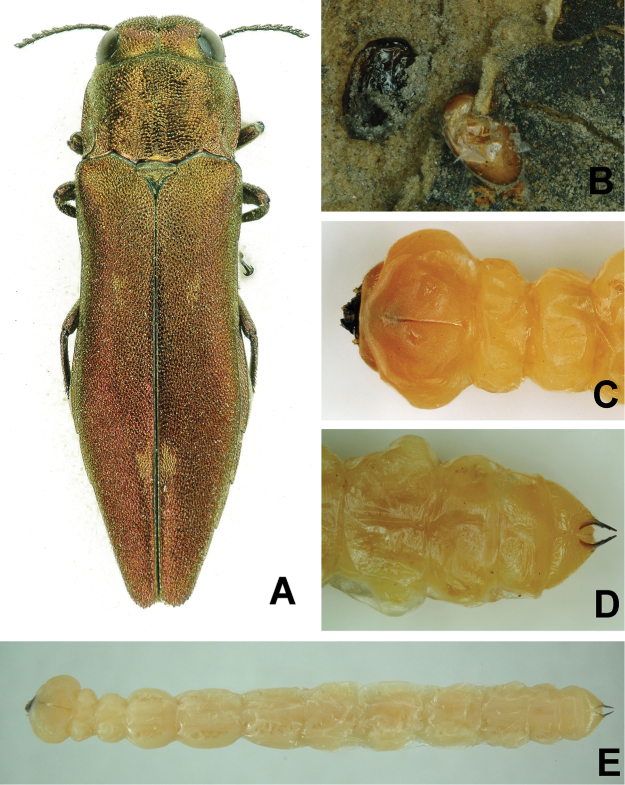
A Adult of A.
maliB Eggs of A.
maliC Head and thorax of larva, dorsal view D Abdominal tip of larva, ventral view E Larva of A.
mali, ventral view.